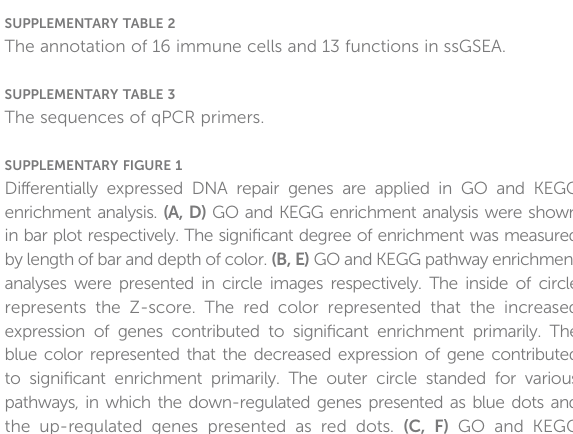
SUPPLEMENTARY TABLE 2 The annotation of 16 immune cells and 13 functions in ssGSEA.